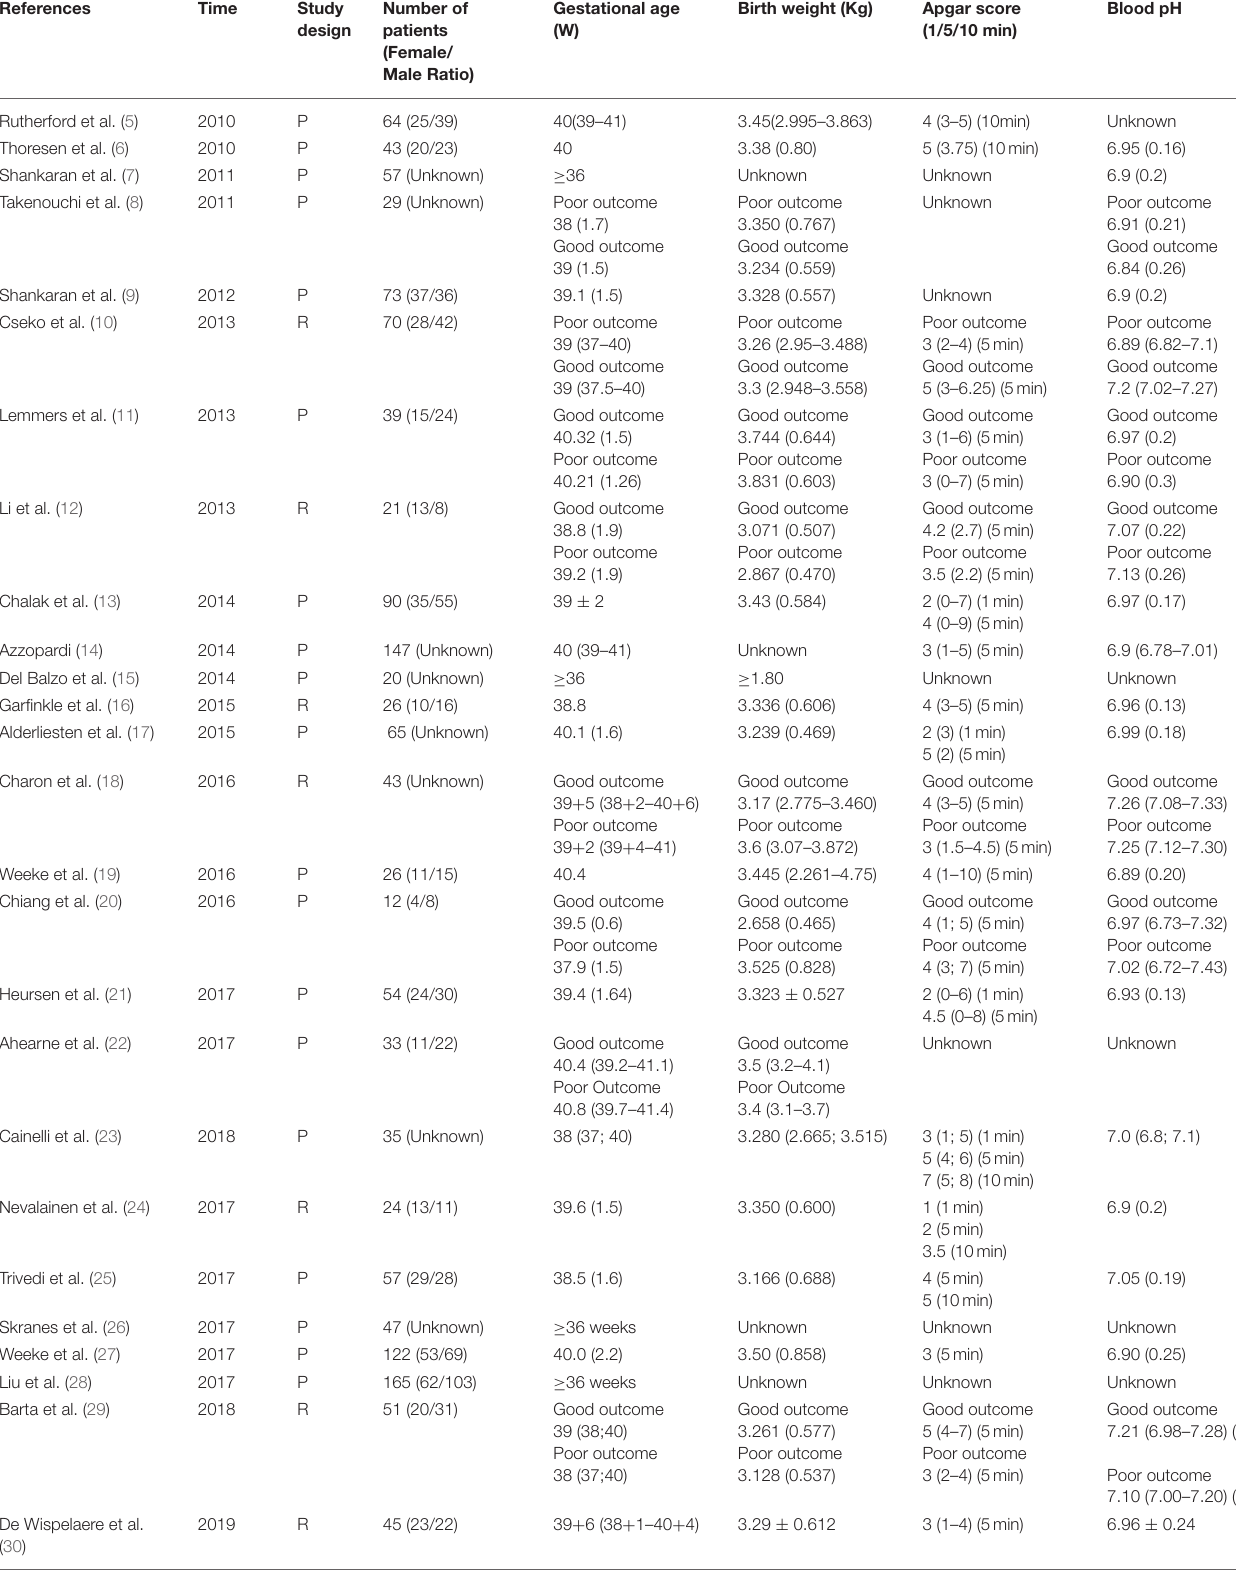
TABLE 1 | Characteristics of included